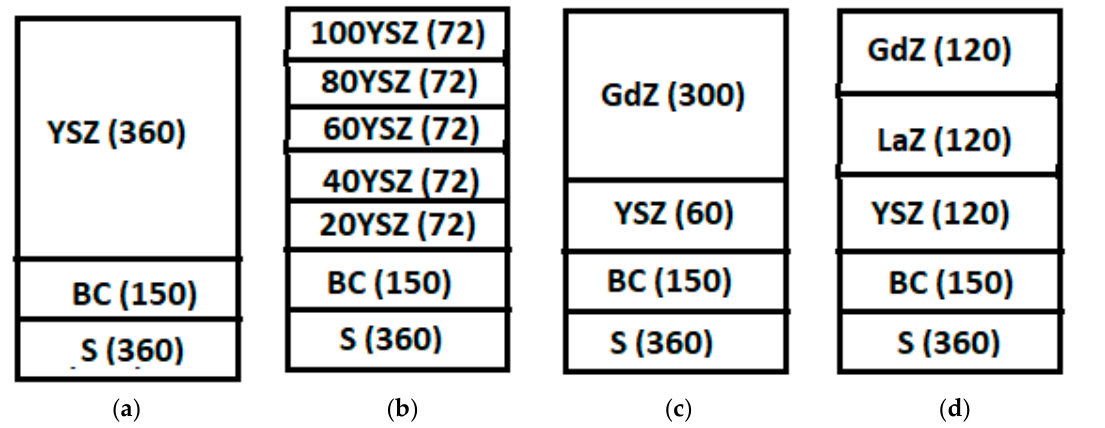
Figure 9. TBC layered architectures as considered for simulations in this work. Each box represents a layer and number in parentheses represents respective thickness of layers in μ : ( a ) Single layer TBC; ( b ) 5-layer FG TBC; ( c ) Bilayer TBC; ( d ) Trilayer Hybrid.